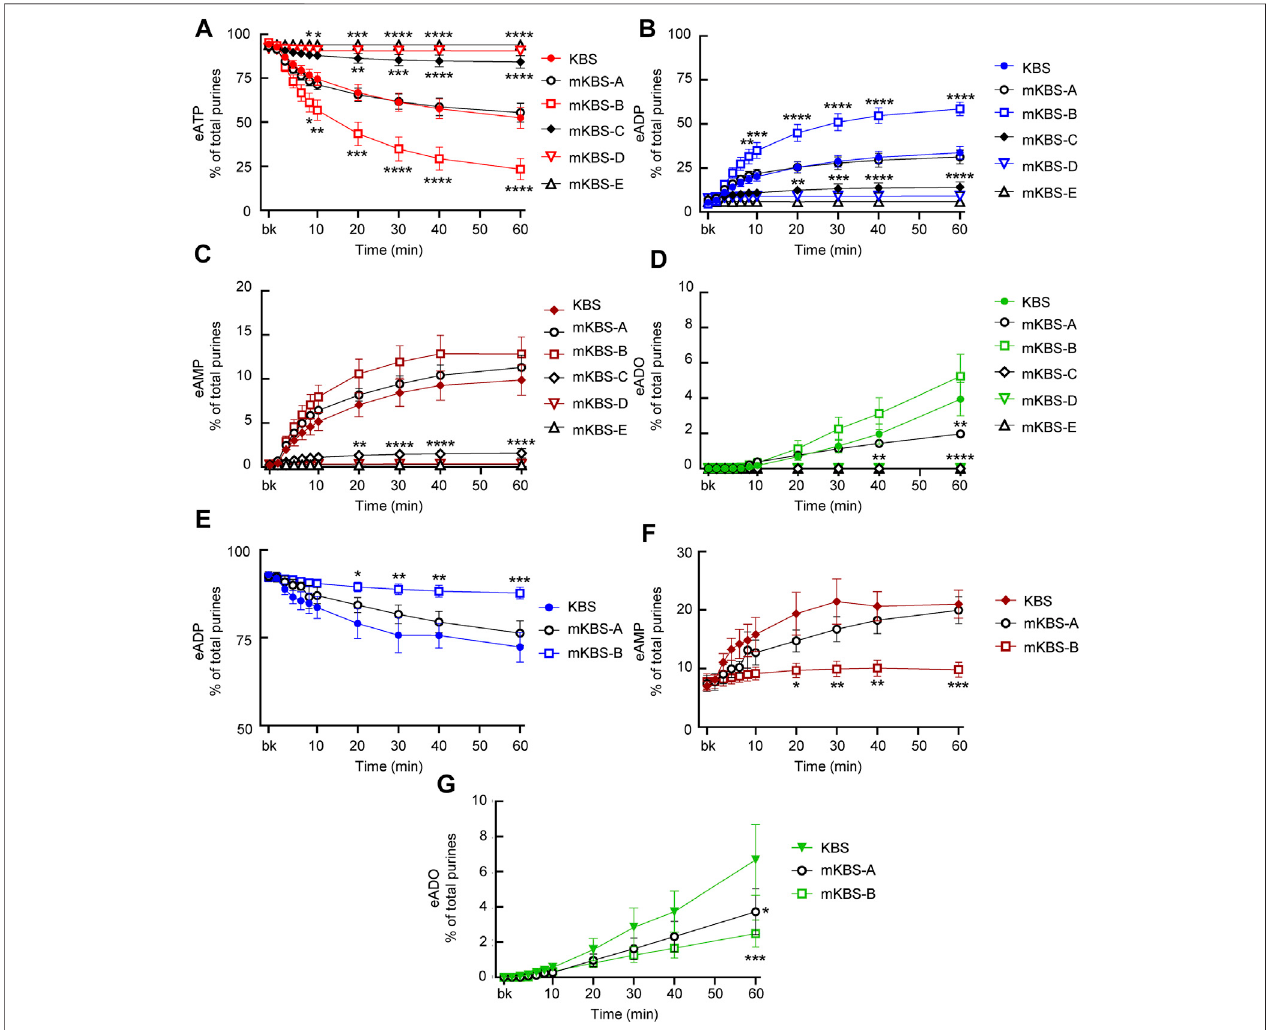
FIGURE6| EffectsofextracellularCa 2+ andMg 2+ onactivitiesofreleasedATPasesandADPases. (A – D) eATPhydrolysisbysolubleenzymesincontrols(KBS)and mKBS: panel (A) shows the decrease of eATP and panels (B – D) show the increase in eADP, eAMP, and eADO formed from eATP, respectively. (E – G) eADP hydrolysis by soluble enzymes in control (KBS) and mKBS: panel (E) shows eADP decrease and panels (F,G) show the increase in eAMP and eADO formed from eADP. KBS contains normal Ca 2+ (1.8 mM) and Mg 2+ (1.2 mM). mKBS-A contains normal Ca 2+ (1.8 mM) and no Mg 2+ (0 mM); mKBS-B contains 0 mM Ca 2+ , normal Mg 2+ (1.2 mM), and EGTA (5 mM); mKBS-C contains 0 mM Ca 2+ , 0 mM Mg 2+ , and EGTA (5 mM); mKBS-D contains 0 mM Ca 2+ , normal Mg 2+ (1.2 mM), EGTA (5 mM), and EDTA(5 mM);mKBS-E contains0 mM Ca 2+ , 0 mM Mg 2+ ,EGTA (5 mM), and EDTA(5 mM). Asterisks denotesigni fi cantdifference from controls (KBS). * p < 0.05, ** p < 0.01, *** p < 0.001, **** p <